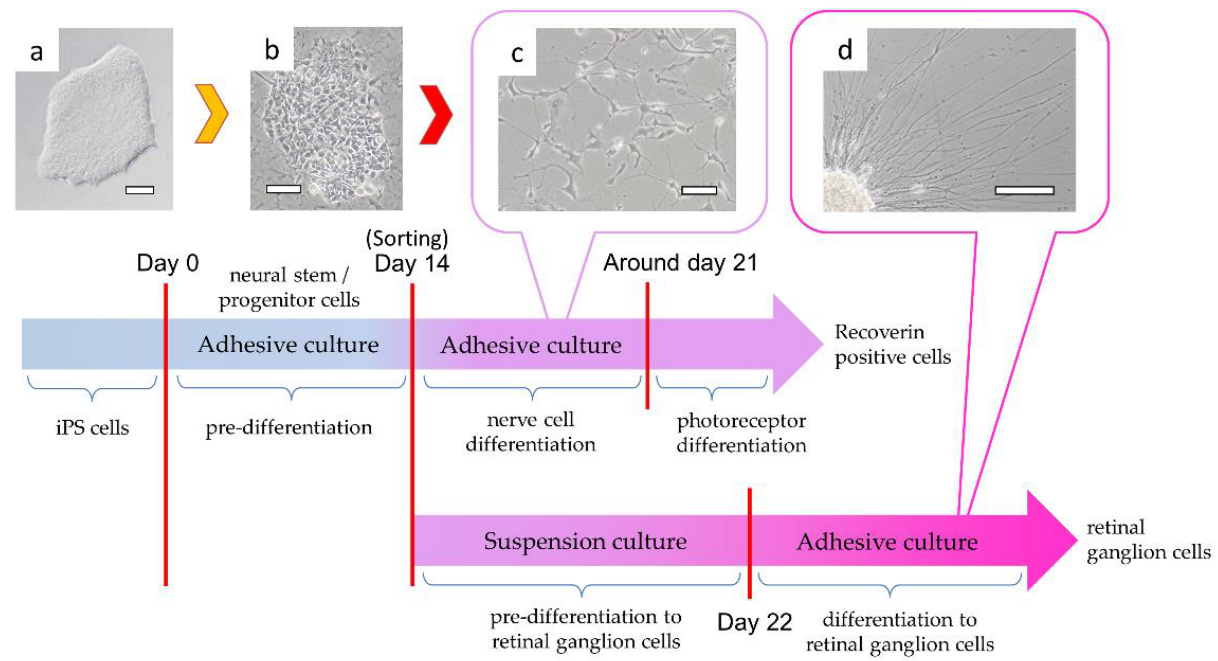
Figure 5. Process of differentiation of H-iris iPS cells to nervous system cells. Cells were pre-differentiated from ( a ) H-iris iPS cells to ( b ) neural stem/progenitor cells by adhesive culture. ( c ) Cells sorted with p75NTR were differentiated into neurons. By changing the medium condition, the nerve cells were differentiated into Recoverin-positive cells. ( d ) In contrast, after suspension culture, neurites were elongated by adhesive culture and differentiated into retinal ganglion cells. Bars: 100 μm.